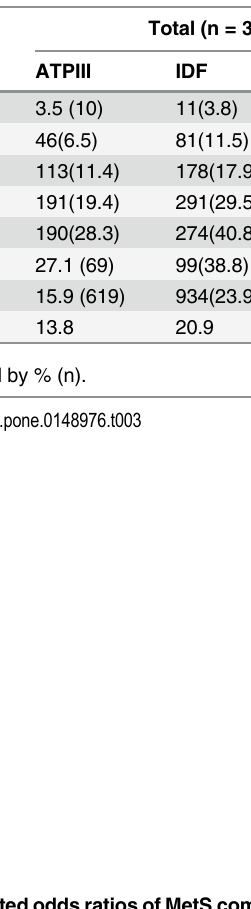
Table 3. Age-specific and age-adjusted prevalence of MetS in Kazakh adults based on criteria of the IDF, ATP III, and JIS.